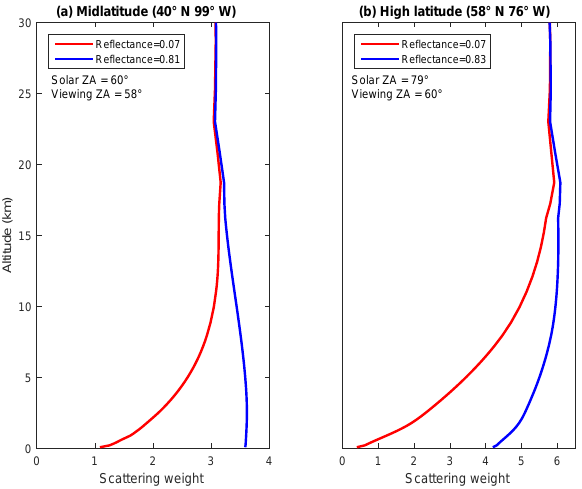
Figure 2. Observation sensitivity to NO 2 . Scattering weight profiles calculated for cloud-free OMI NO 2 retrievals, with and without sur- face snow cover, for January 2013 at (a) 42 ◦ N, 99 ◦ W with a solar zenith angle (ZA) of 60 ◦ and (b) 58 ◦ N, 76 ◦ W with a solar zenith angle of 79 ◦ .